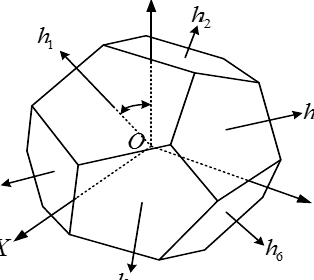
Figure 2. The hexad system configuration (2 α = 63 ◦ 26 (cid:48) 5.8 (cid:48)(cid:48) ).